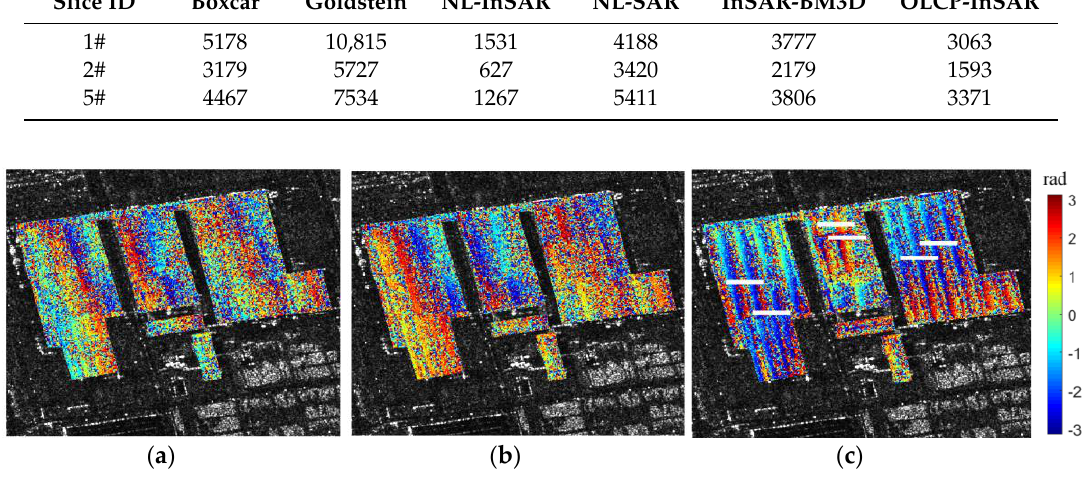
Figure 17. The interferograms in the real InSAR tensor. Color bar of the range value is shown for each channel with pointers to indicate the true values. There are small visual differences between slices. For example, the phase pattern of ( c ) is strongly related to the structure of the roof. ( a ) The first slice. ( b ) The second slice. ( c ) The fourth slice of the real InSAR tensor. Remote Sens. 2020 , 12 , x FOR PEER REVIEW